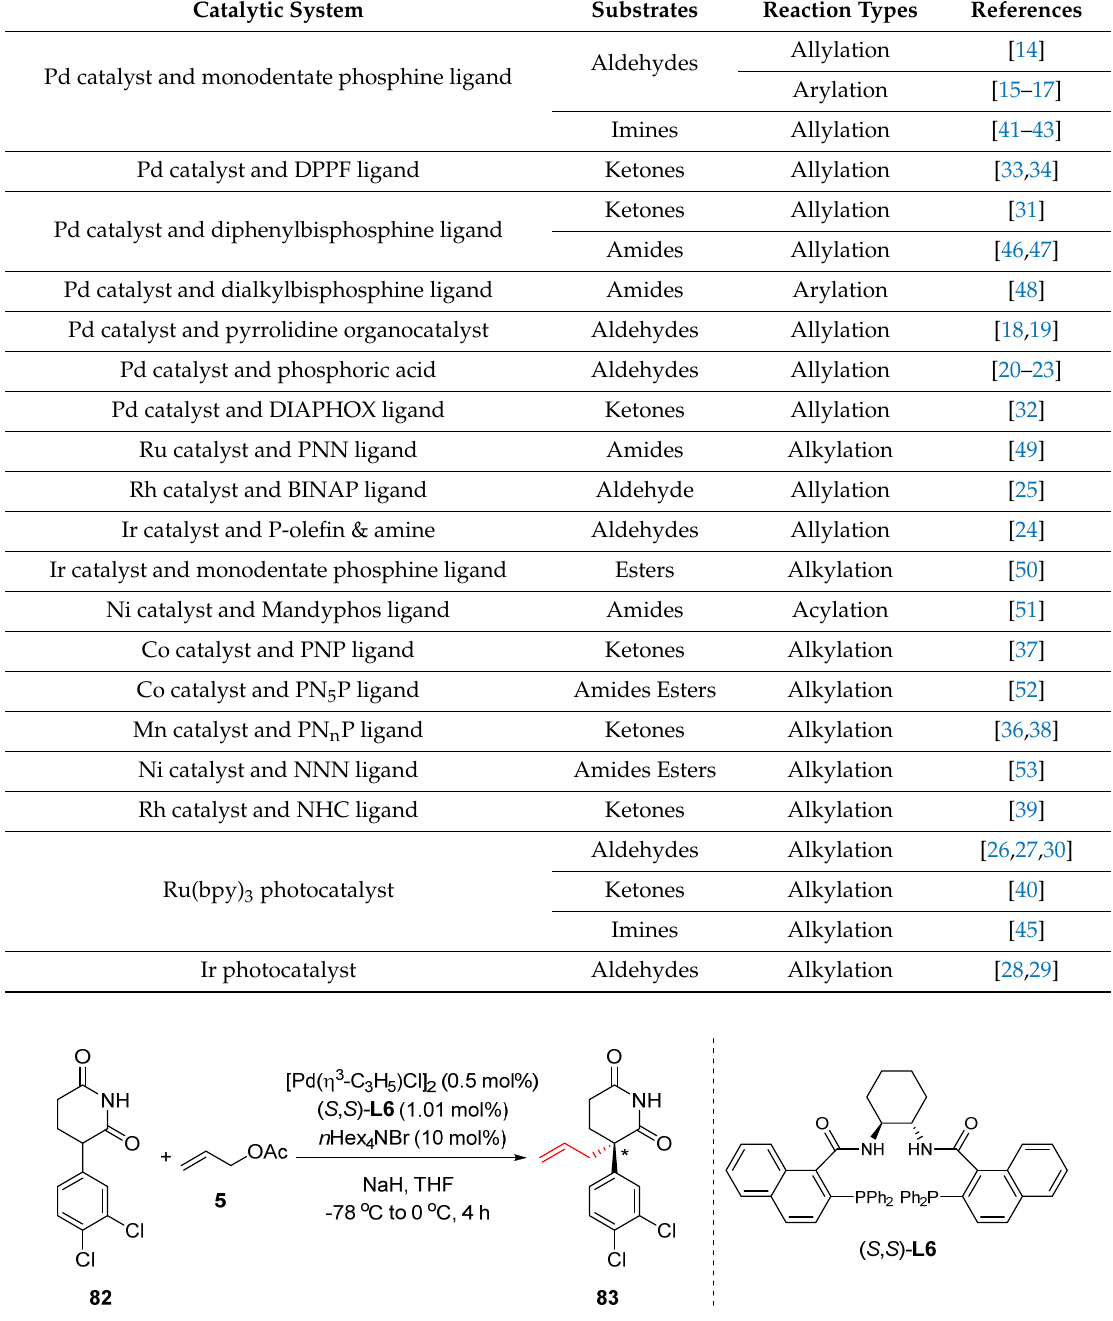
Table 1. Various catalytic systems for the α -alkylation of carbonyl